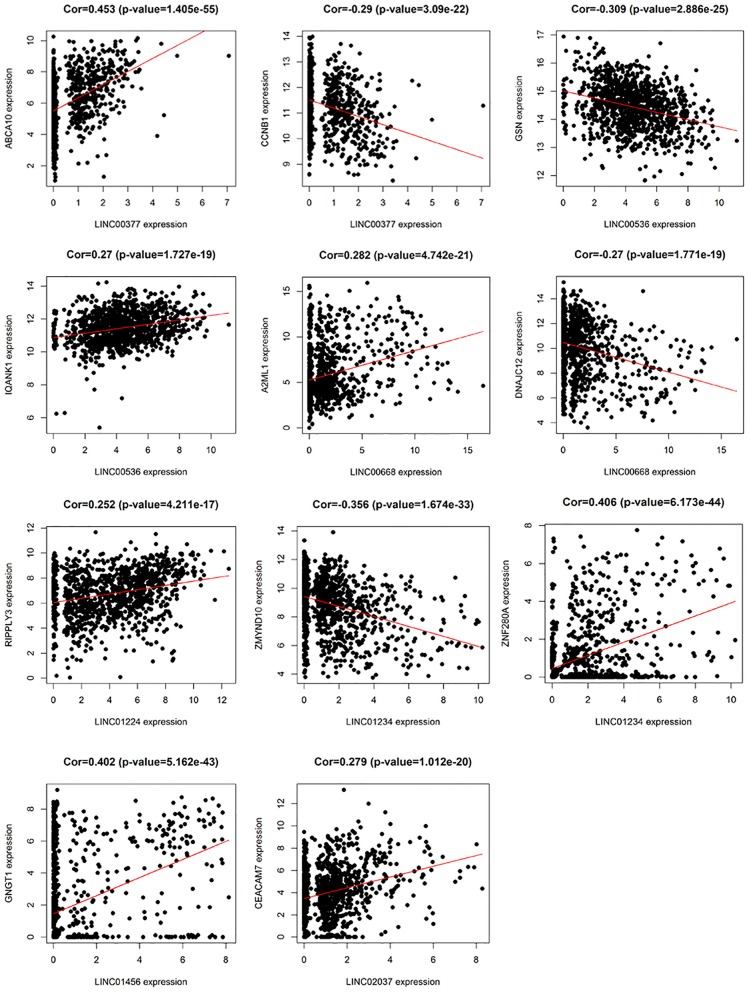
The relationship between 7 lncRNAs and related mRNAs (only the mRNAs that are most positively and negatively correlated with 7 lncRNAs are listed according to the correlation coefficient).